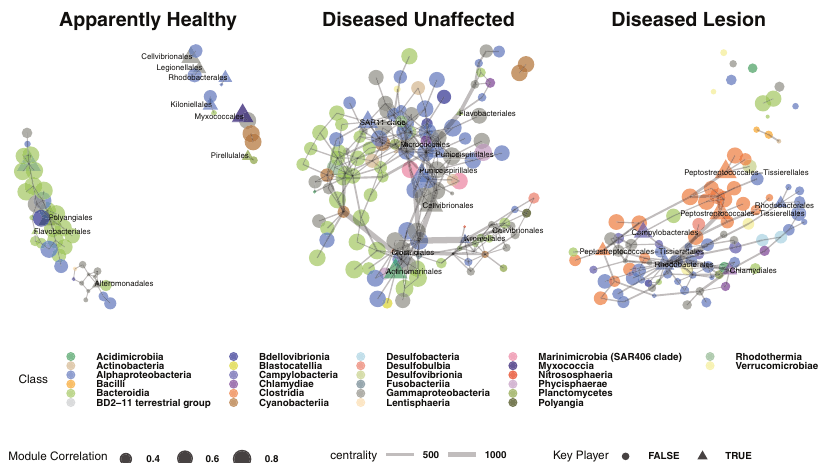
Fig. 7 Co-occurrence networks of bacteria from weighted correlation network analysis (WGCNA) modules (Supplementary Fig. 7) among apparently healthy colonies (AH), and unaffected (DU) and lesion (DL) areas on diseased colonies. The nodes represent amplicon sequence variants (ASV), which are sized by the ASV ’ s correlation value to its respective module. A triangle and label of the bacteria order denote that a node is a “ key player. ” The width of the edges corresponds to centrality, with thicker edges representing higher centrality. Samples from the three coral compartments (i.e., mucus, tissue slurry, and tissue slurry skeleton) were included in the analysis, and Acropora spp. samples were excluded from this